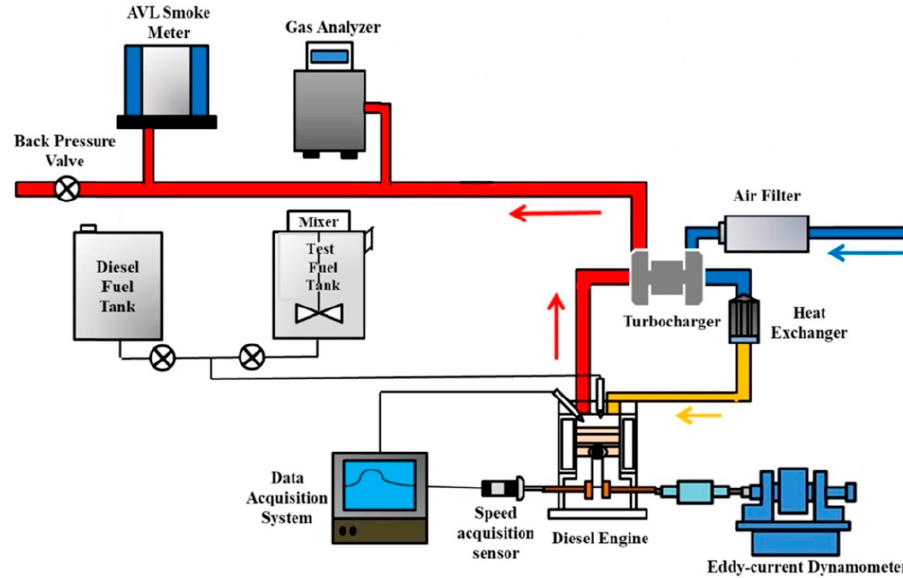
Figure 1. Schematic layout diagram of the experimental system. Table 1. Engine specifications.